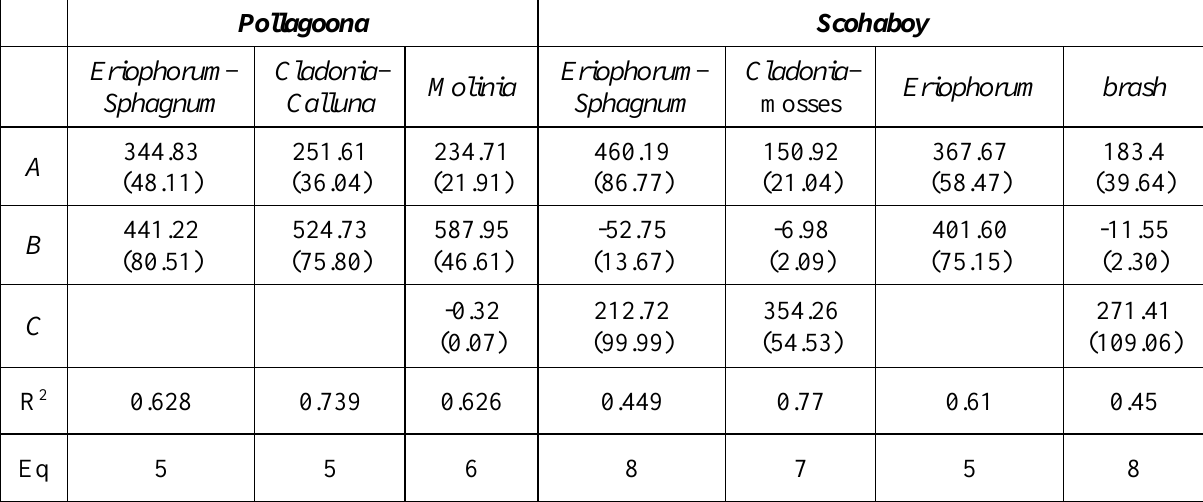
Table A2. Estimated parameter values and goodness of fit (r 2 ) for R number of the equation used (see page 6) is given for each microsite type. Model errors for each parameter are shown in